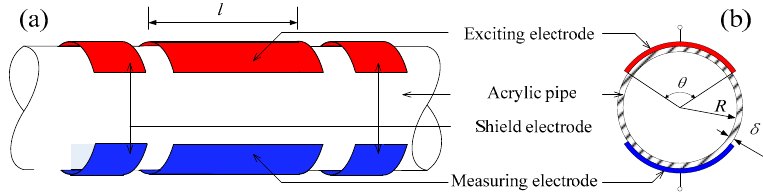
Figure 1. Structure of the concave capacitance sensor for capacitive phase shift detection. ( a ) 3D view; ( b ) cross section view.